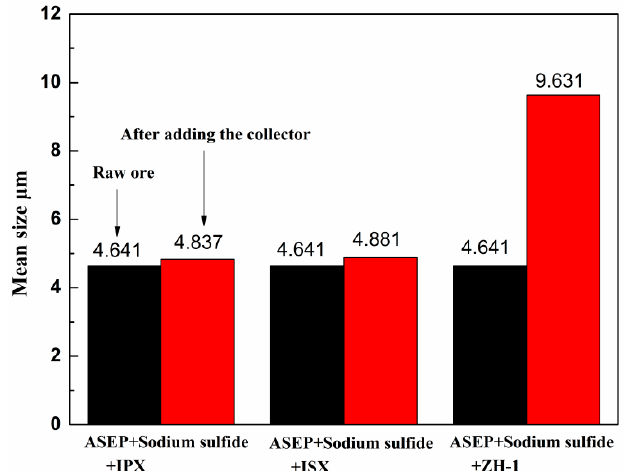
Figure 7. The e ff ect of di ff erent collectors on the average particle size of malachite ( − 10 µ m).